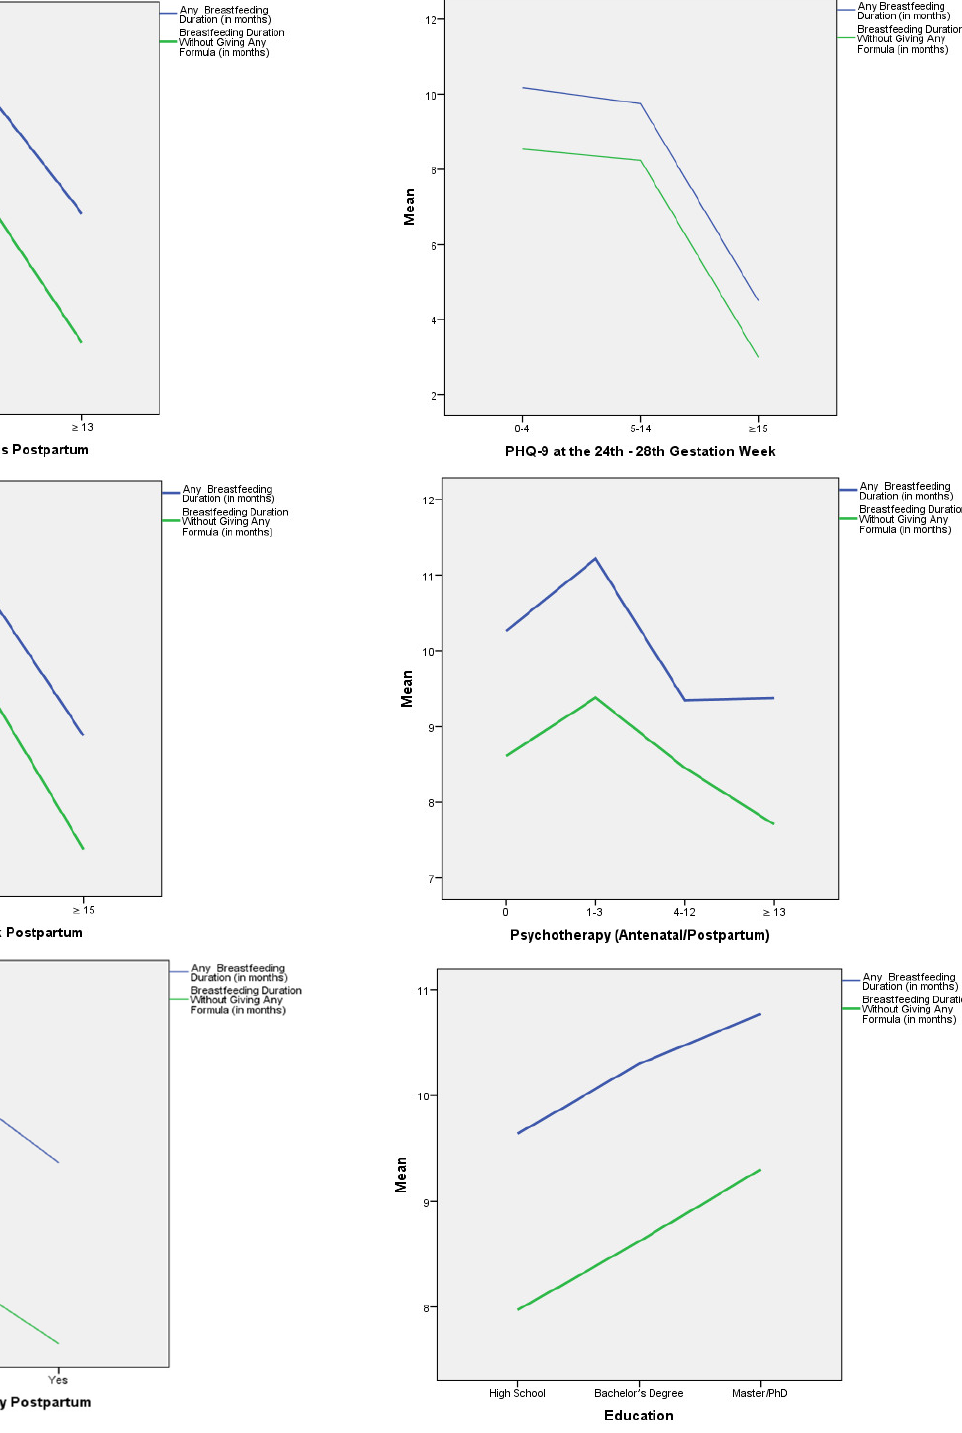
Figure 2. The means of any breastfeeding duration and breastfeeding duration without giving any formula according to women’s mental health characteristics in the perinatal period.